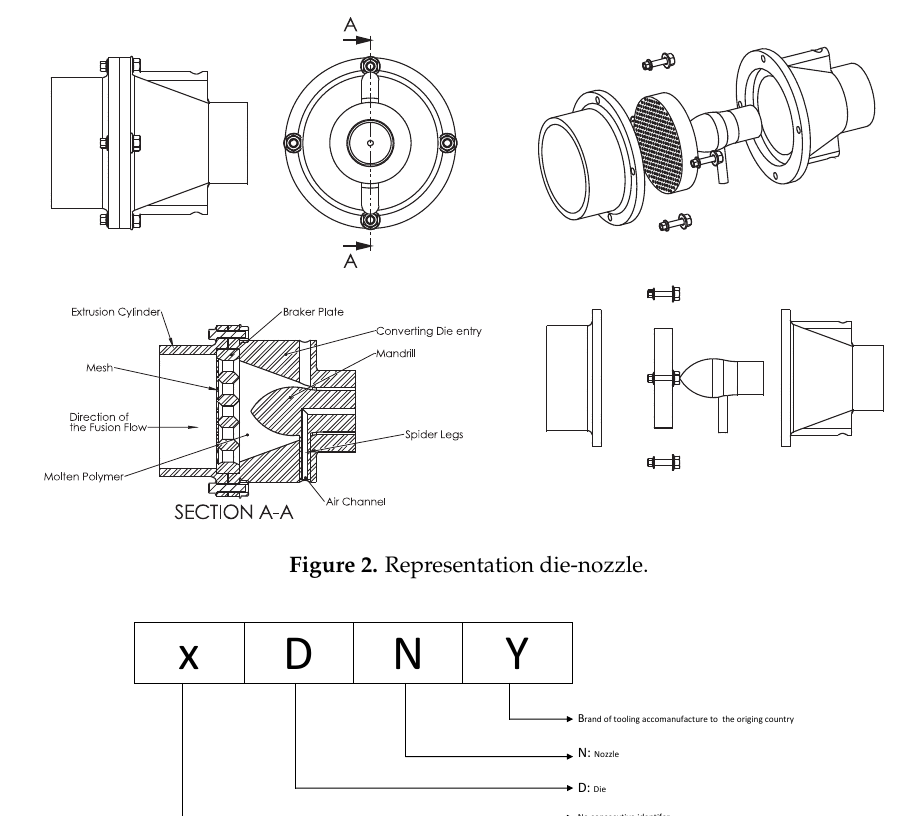
Figure 3. Tooling code for industrial protection purposes